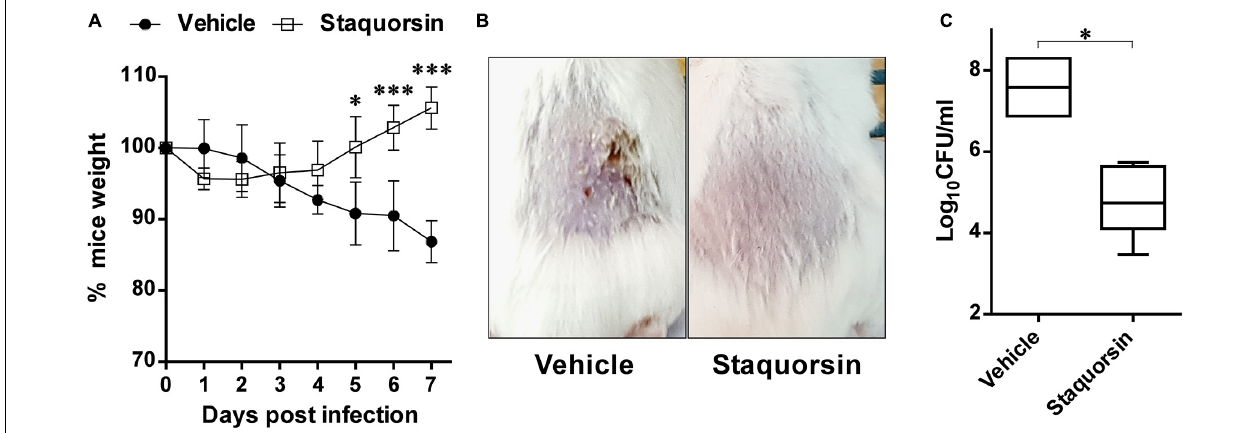
FIGURE 6 | Staquorsin is effective in controlling S. aureus skin infection. (A) Monitoring the weights of the mice throughout the course of the infection. The weights of mice were determined every 24 h and they are presented as percentages of the weights at day 0. The data presented is the average of the readings of the mice in each group; treated with the vehicle (closed circles) and staquorsin (open squares), and the error bars represent the standard deviation. Statistical analyses were performed by applying an unpaired t test for each pair representing the readings at the indicated time point. (B) Photographs of a representative mouse of each group (treated with vehicle vs staquorsin). The images were taken on day seven post-infection. (C) Box plots of the bacterial loads in the skin lesions of mice infected with S. aureus and treated with either the vehicle or staquorsin. The data is presented as Log 10 CFU/ml obtained following plating the homogenates of the skin lesions excised from the infected mice. The whiskers span the difference between the minimum and maximum readings; the horizontal bar represents the mean. The “ ∗ ” indicates a p- value ≤ 0.05, and “ ∗∗∗ ” p- value ≤